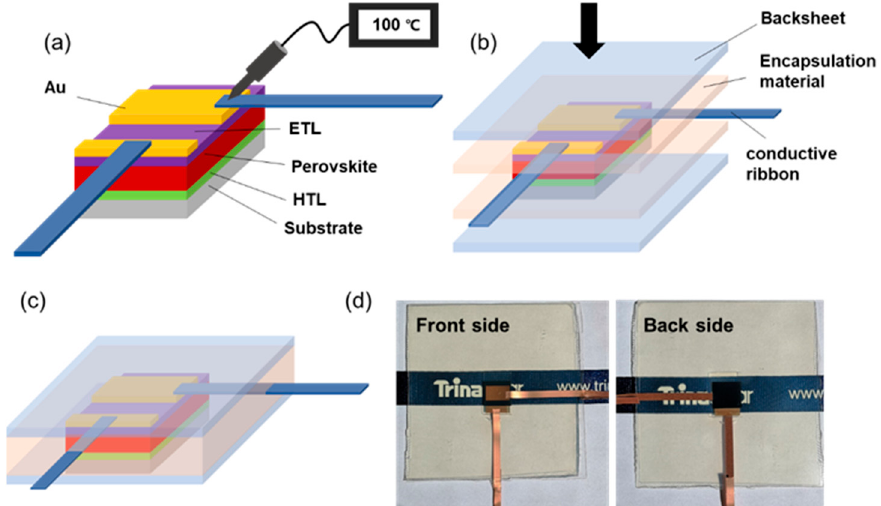
Figure 1. ( a – c ) The diagrammatic sketch of encapsulation procedure. ( d ) The digital photos of encapsulated PSC.